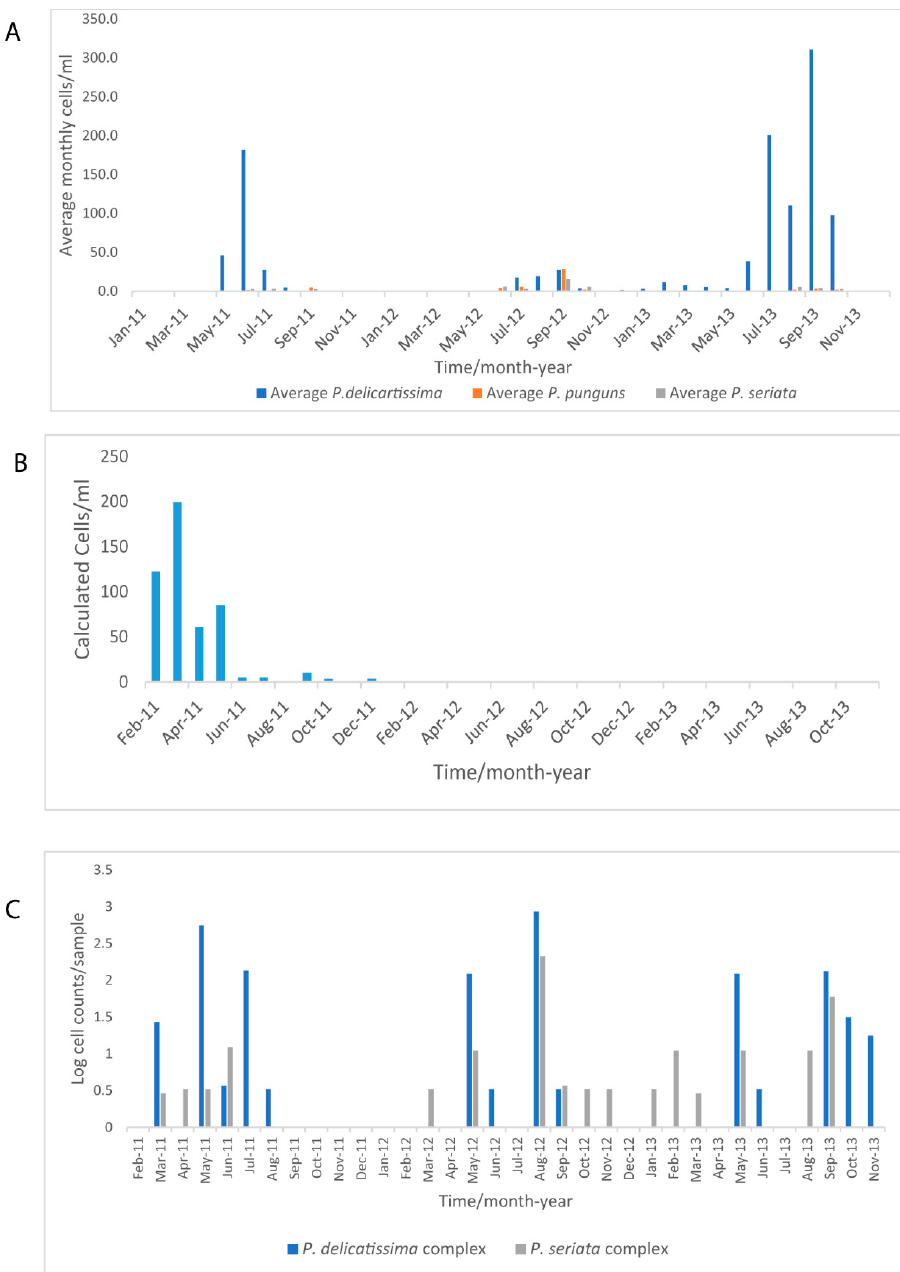
Figure 3. Comparison of P. delicatissima, P. pungens and P. seriata species complex cell concentrations measured by microscopy at WCO L4 ( A ) and P. delicatissima calculated cell concentrations from qRT-PCR species-specific test, averaged over all stations ( B ) and by semi-quantitative cell counts per sample from Continuous Plankton Recorder survey PR route ( C ) from 2011 to 2013.